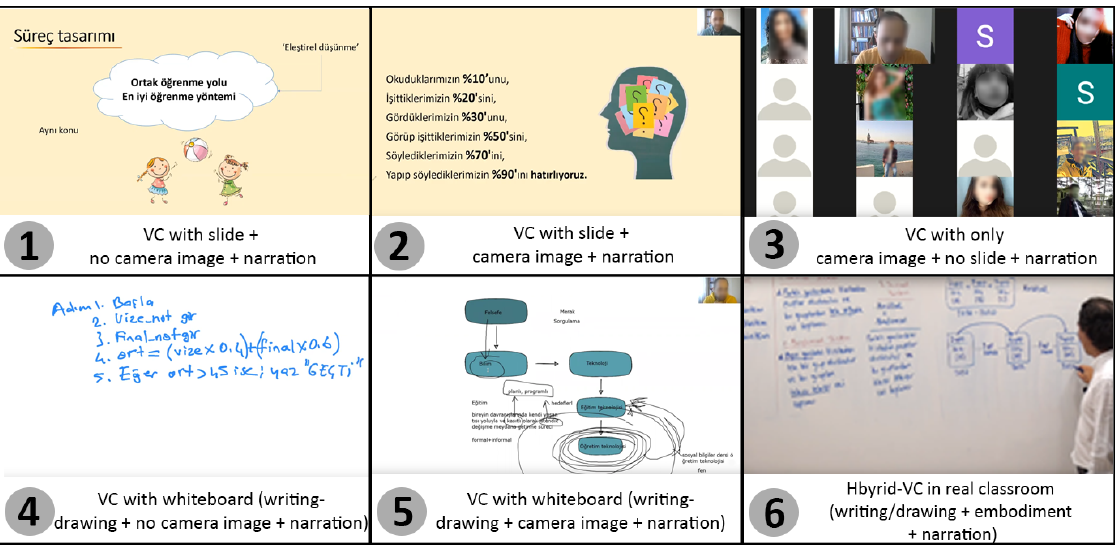
Screenshots of VCs: Combinations of Synchronous